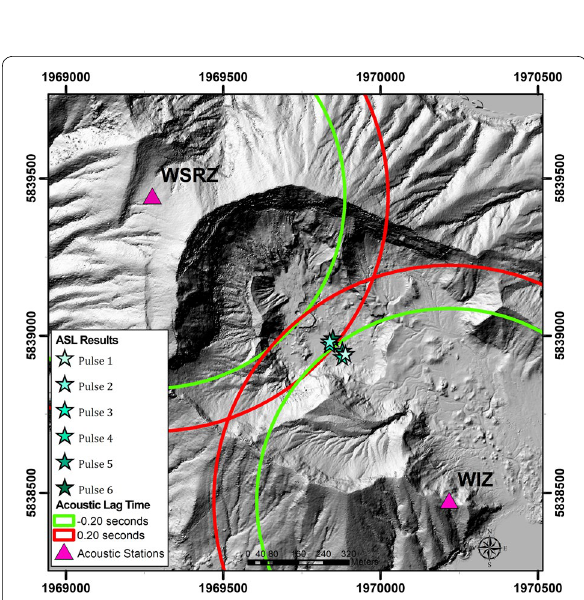
Fig. 13 Map projection of Whakaari showing the acoustic lag time range ( 0.20 to 0.20 s) from the acoustic data projected as distance − radii from each station. Acoustic lag times at an air velocity of 340 m/s equate to a distance range between 611 m (green circles) and 748 m (red circles) away from each station. The calibrated ASL results for each eruption pulse from Fig. 8 are also plotted as green